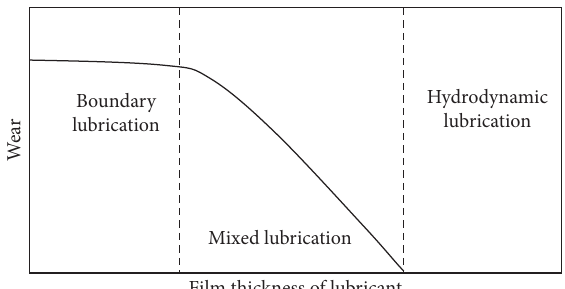
Figure 2: Relation between wear and lubricant film thickness in various regimes (adopted from [131,